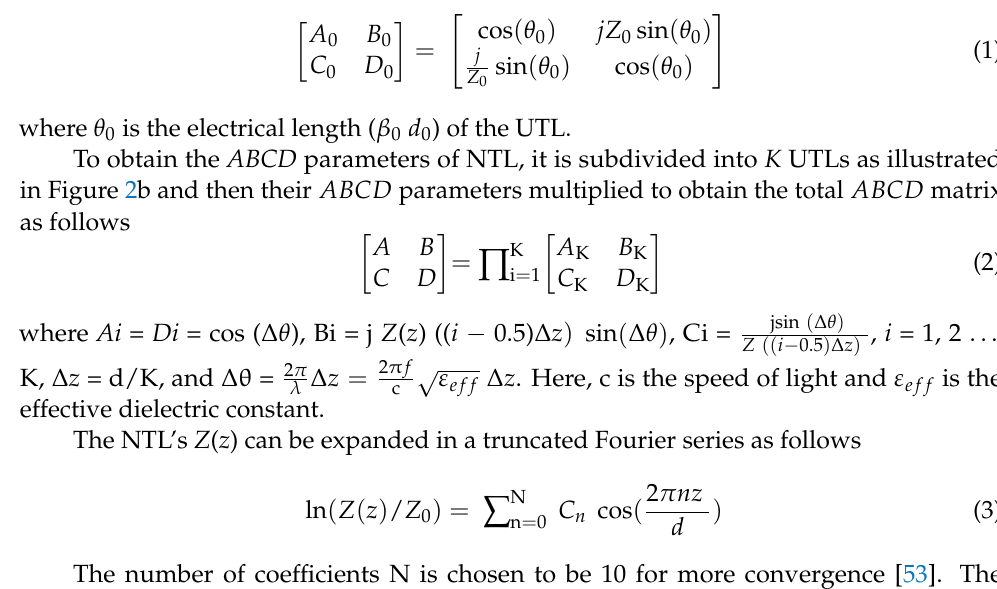
Figure 2. ( a ) UTL and ( b ) NTL with its subdivision into K uniform